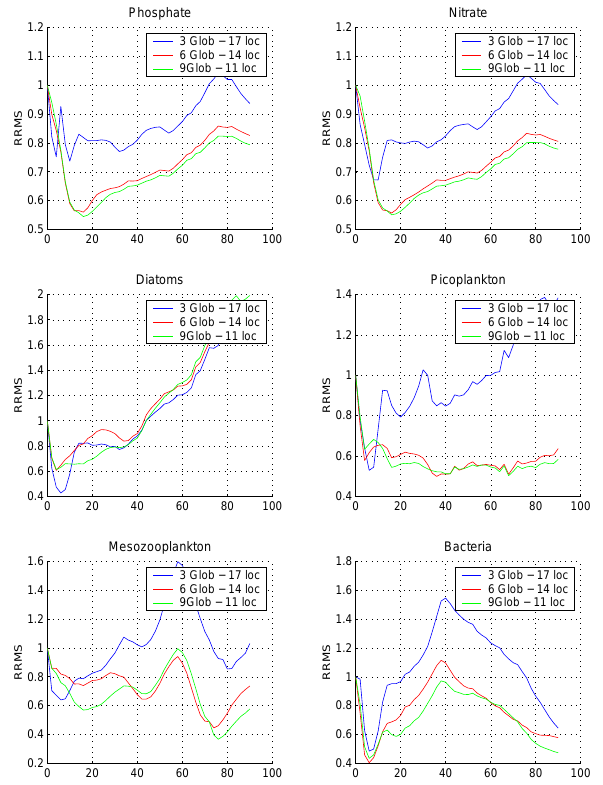
Fig. 13. Evolution in time of phosphate, nitrate, diatoms, picoplank- ton, mesozooplankton and bacteria RRMS in the deep ocean from the SFPLEK filter assimilating sea color data using global-local EOFs from the vertical decomposition with: (i) 6 global - 14 lo- cal EOFs, and (ii) 9 global - 11 local